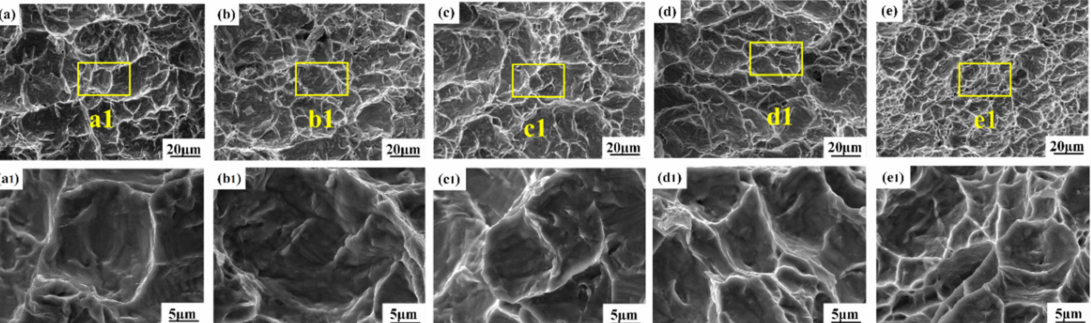
Figure 14. Morphology of the fracture surface of Zr-4Hf-3Nb (wt%) alloy. with various cooling rate: